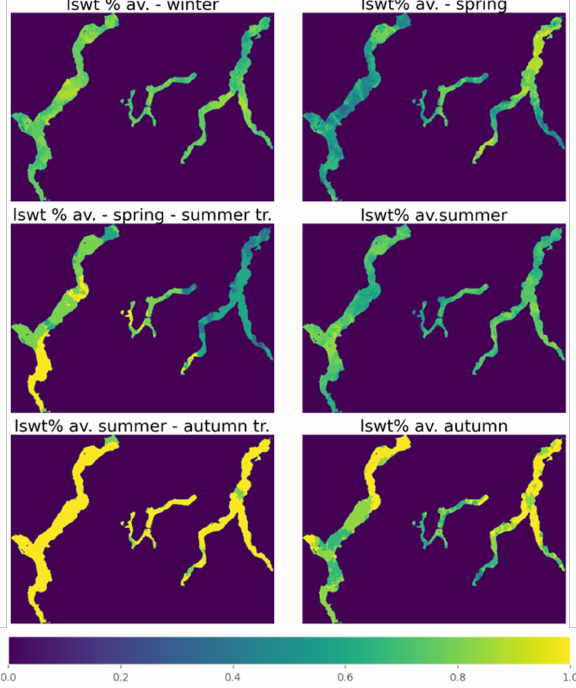
Figure 4. Data availability - LSWT, per season.